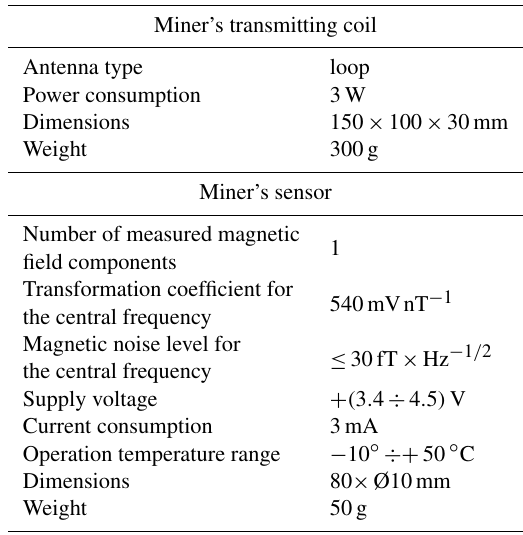
Table 1. Main parameters of miner’s responder beacon prototype.